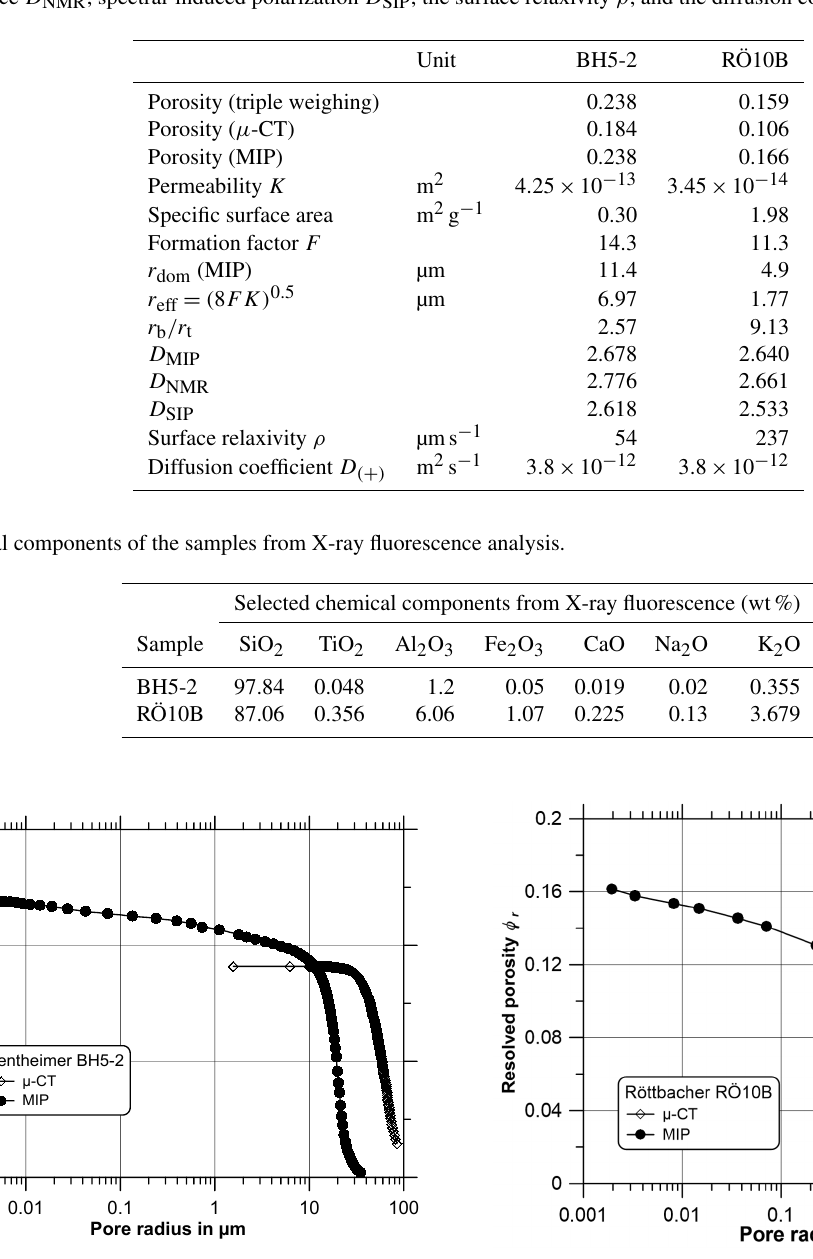
Table 1. Petrophysical properties of the samples: porosity φ , permeability K , specific surface area S m , formation factor F , dominant pore radius r dom , effective pore radius r eff , the ratio r b /r t , fractal dimensions determined from mercury intrusion porosimetry D MIP , nuclear magnetic resonance D NMR , spectral-induced polarization D SIP , the surface relaxivity ρ , and the diffusion coefficient D ( + ) .